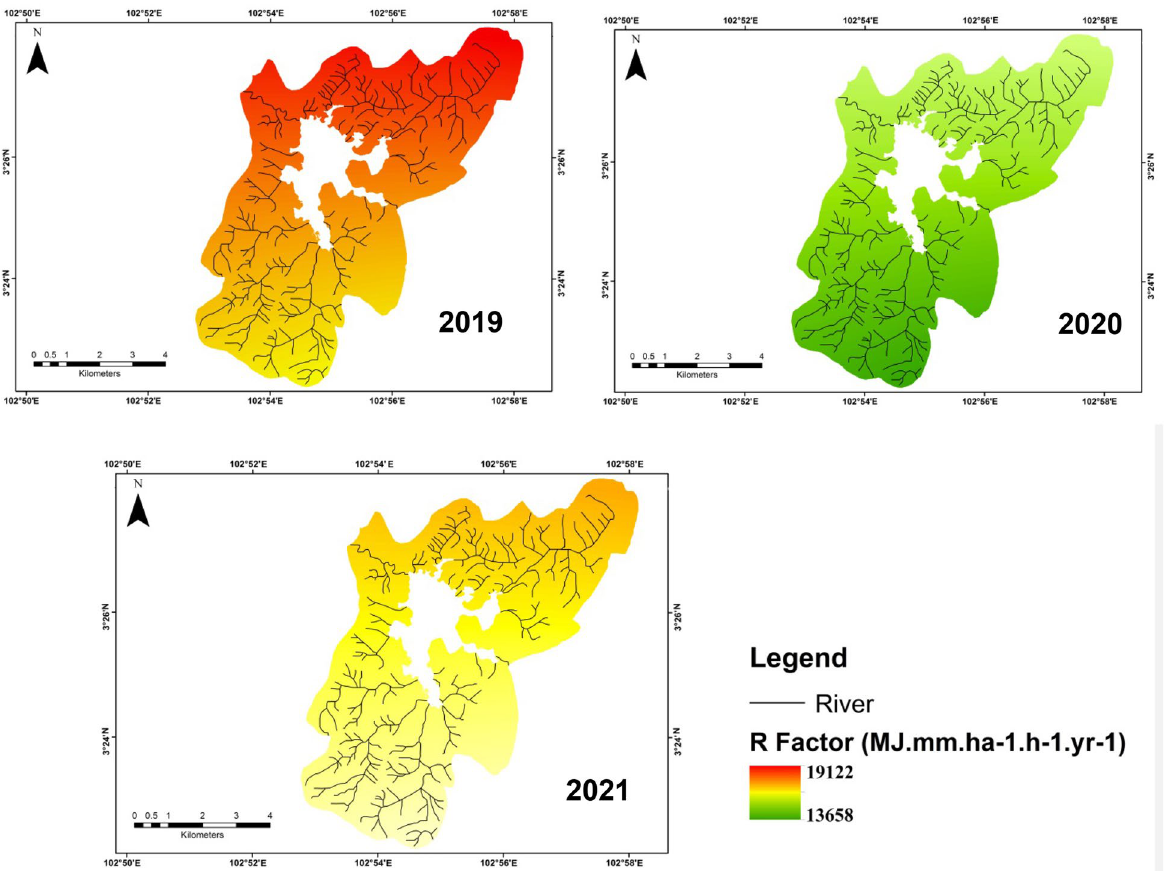
Fig. 2 R factor distribution (2019; 2020; 2021) in Chini lake basin